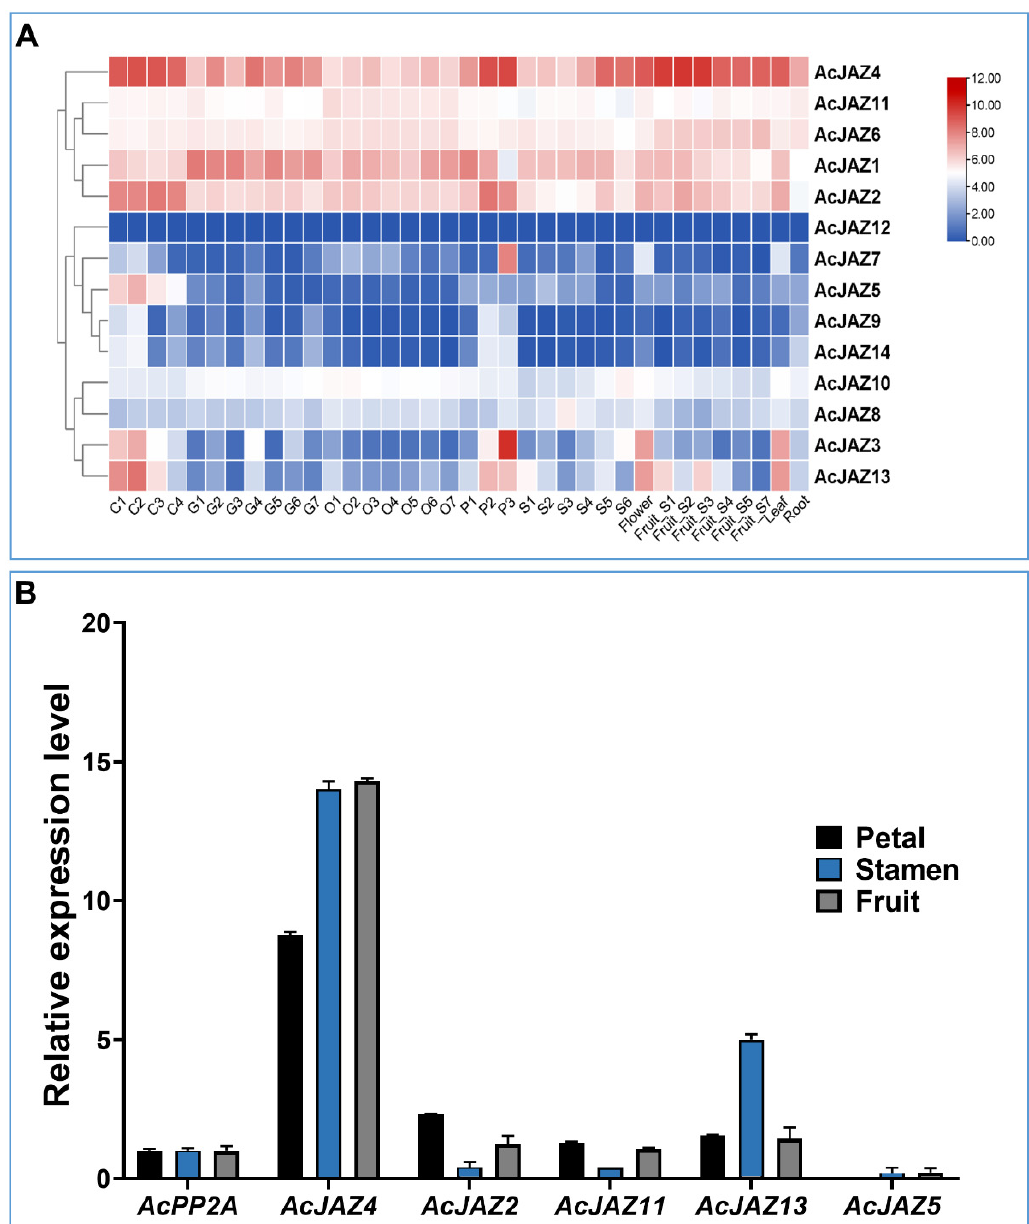
Figure 3. Expression of AcJAZ genes in various tissues. ( A ) Heat-map shows the expression profiles of AcJAZ genes in nine different tissues. C1–C4 (Calyx stage 1–4), G1–G7 (Gynoecium stage 1–7), O1–O7 (Ovule stage 1–7), P1–P3 (Petal stage 1–3), S1–S6 (Stamen stage 1–6), Flower, Fruit _S1–S7, leaf, root. The scale indicates log 10 transformed gene expression by colors ranging from red (high) to blue (low). ( B ) The expression of AcJAZ4, AcJAZ2, AcJAZ11, AcJAZ13, and AcJAZ5 in petal, stamen, and fruit determined by RT-qPCR. AcPP2A was used as the reference.